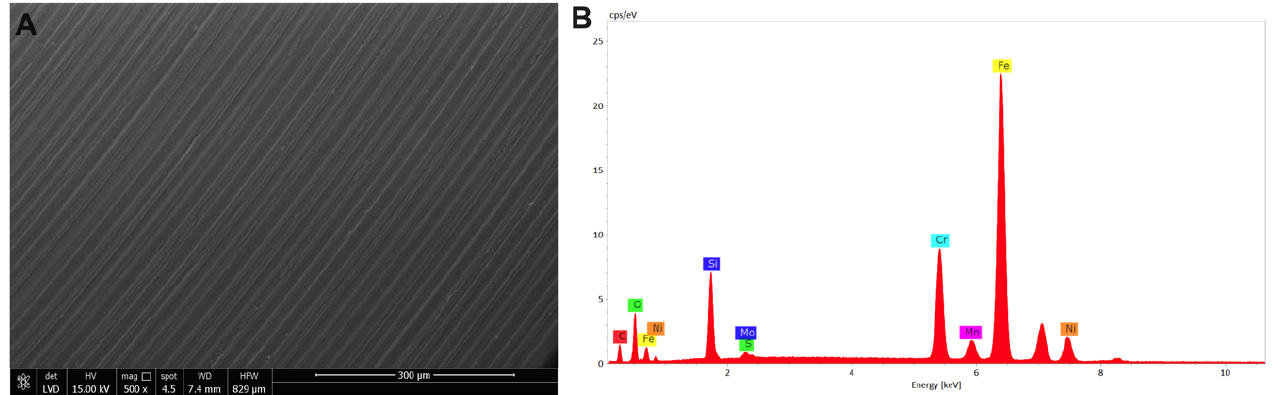
Figure 12. Environmental scanning microscopy morphological analysis on a ( A ) nanoXHAM ® D ‐ treated stainless steel disk surface observed at 300 μ m along with its ( B ) X ‐ EDS microanalysis.